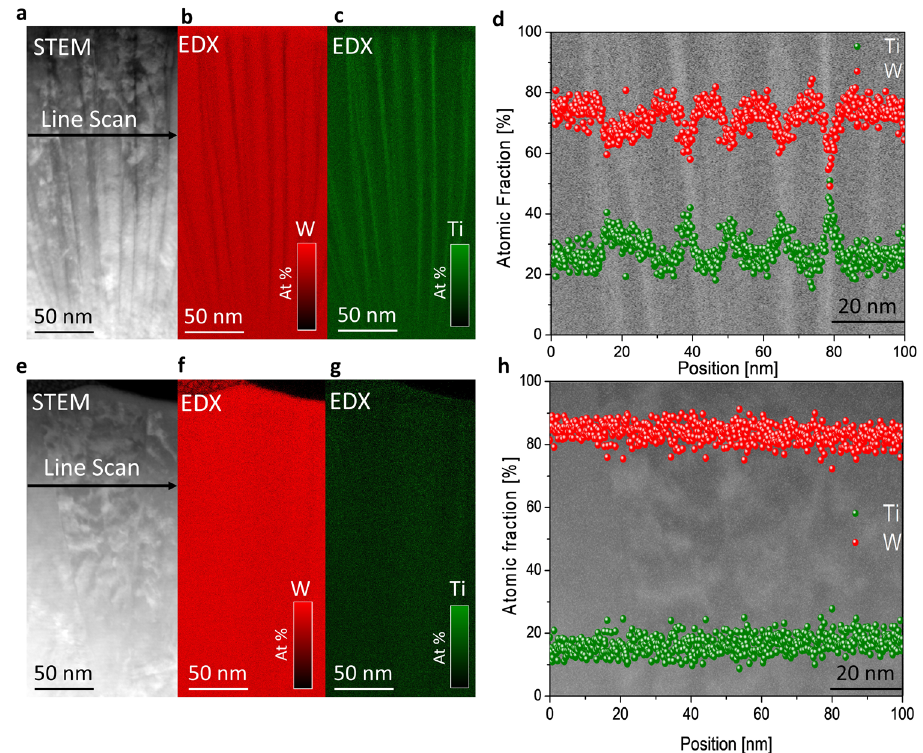
Fig. 4 ADF STEM and STEM-EDX analysis of the 30 at% and 20 at% Ti nanocrystalline W 1-x Ti x thin fi lms. a Cross-sectional ADF STEM image for 30 at% Ti. b W element map (red) for 30 at% Ti. c Ti element map (green) for 20 at%Ti. d Projected line scan for W (red) and Ti (green) on the ADF STEM image for 30 at% Ti. e Cross-sectional ADF STEM image for 20 at% Ti. f W element (red) map for 20 at% Ti. g Ti element map (green) for 20 at% Ti. h Projected line scan for W (red) and Ti (green) on the ADF STEM image for 20 at%